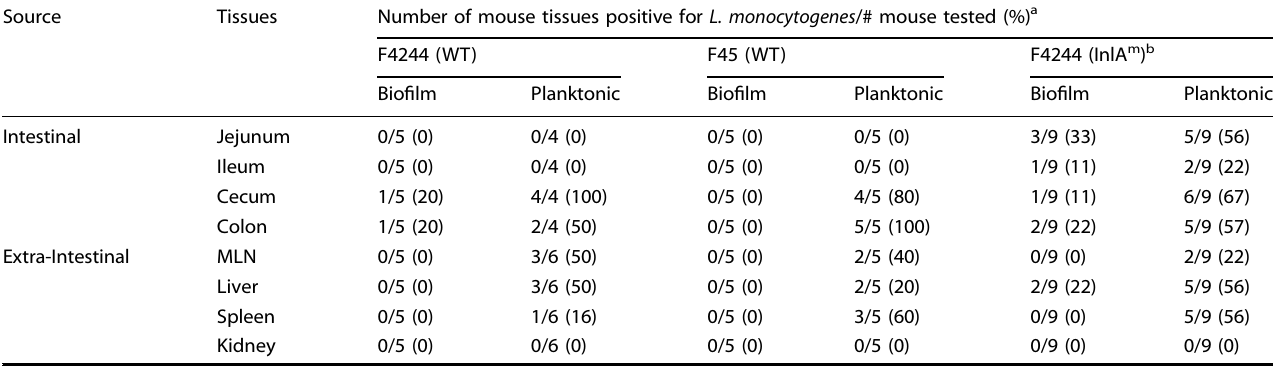
Table 1. Listeria monocytogenes strains (F45, F4244, and F4244 InlA m ) translocation in C57BL/6 mice organs/tissues 12 h after oral